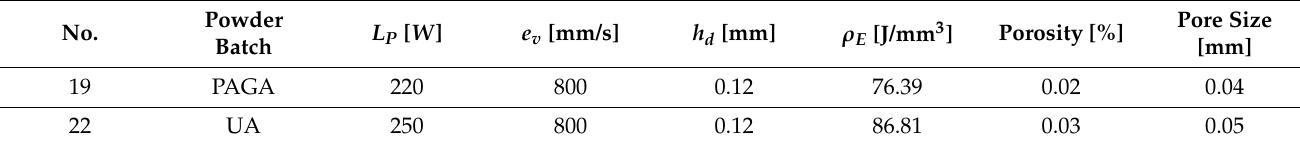
Table 5. Parameters selected for tensile samples.